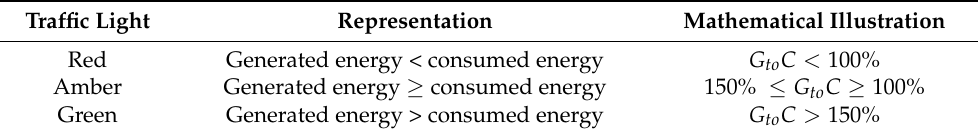
Table 4. Traffic Light Index.